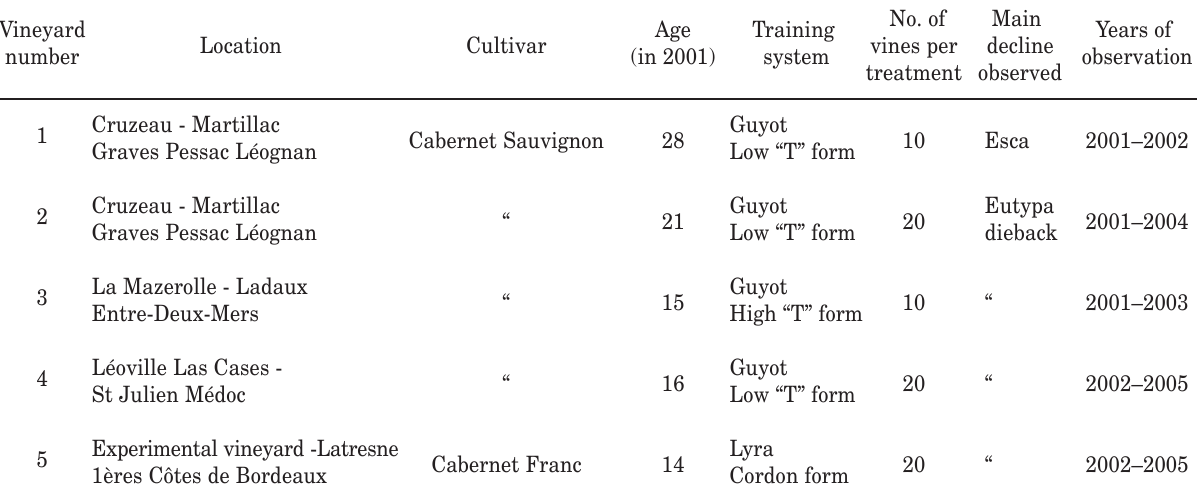
Table 1. Main characteristics of the Bordeaux vineyards in which the experiments were performed.